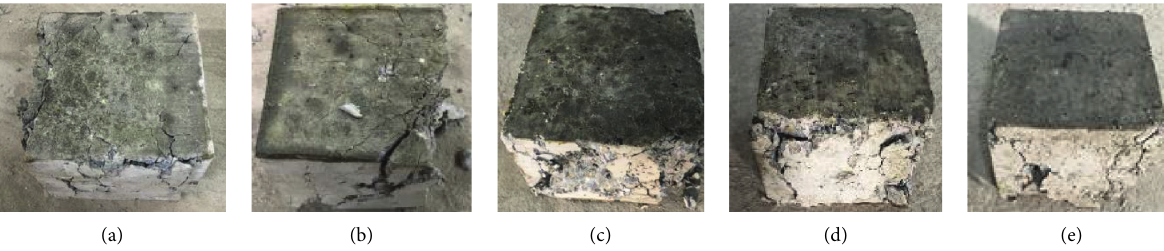
Figure 3: Compressive failure modes of rubber concrete with different substitution rates. (a) 0%, (b) 10%, (c) 20%, (d) 30%, and (e) 40%.